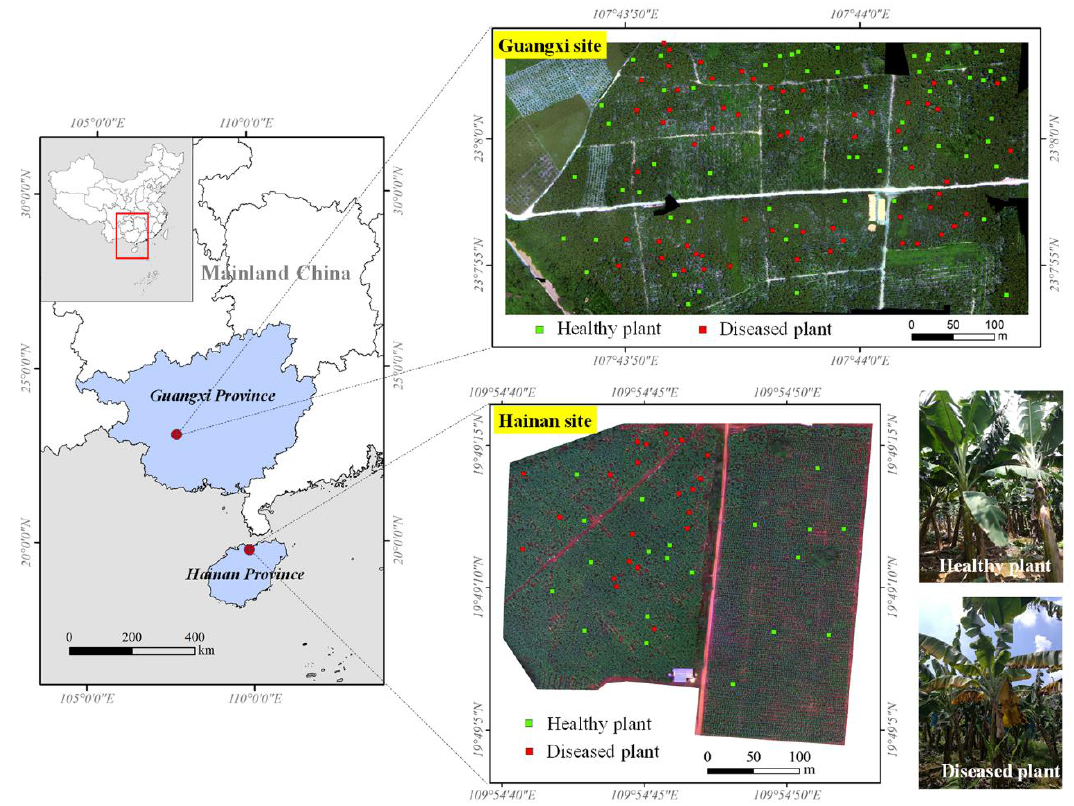
Figure1. Figure 1. Location of the experimental sites with the distribution of survey sites in the banana plantations.